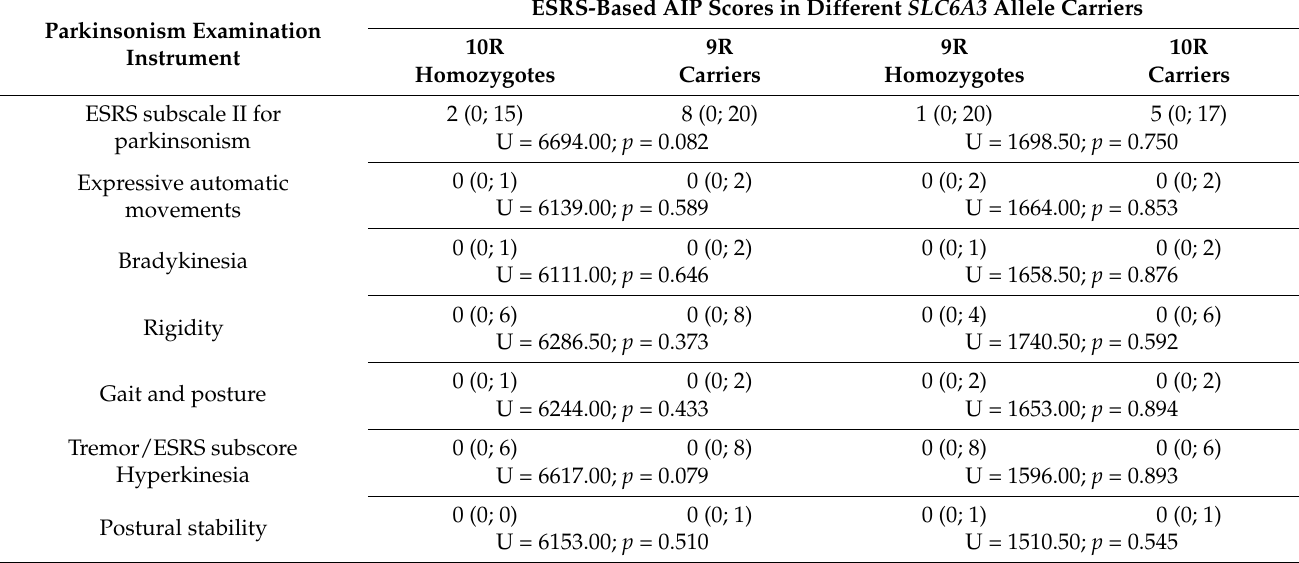
Table 4. ESRS-based AIP scores in haloperidol-treated schizophrenia patients with different SLC6A3 3 (cid:48) UTR VNTR